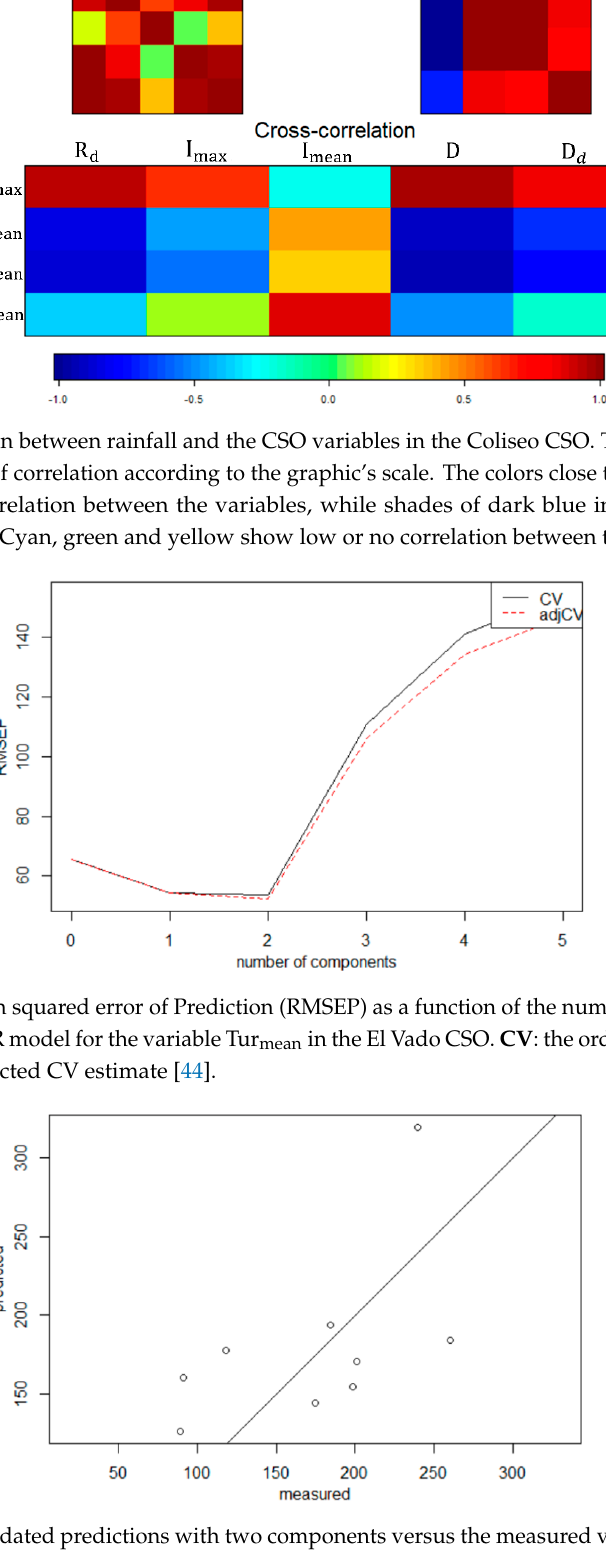
predicted mean turbidity for the El Vado CSO. The dots represent the mean turbidity values measured and